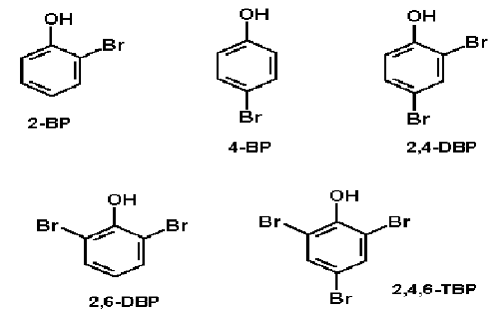
Fig. 1 – Simple bromophenols: 2-bromophenol (2-BP); 4-bromo- phenol (4-BP); 2,4-dibromophenol (2,4-DP); 2,6-dibromophenol (2,6- DP) and 2,4,6-tribromophenol